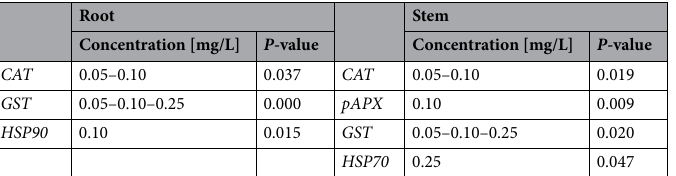
Table 3. Significantly different concentration levels for the expression of each gene in the root and stem structures of L.